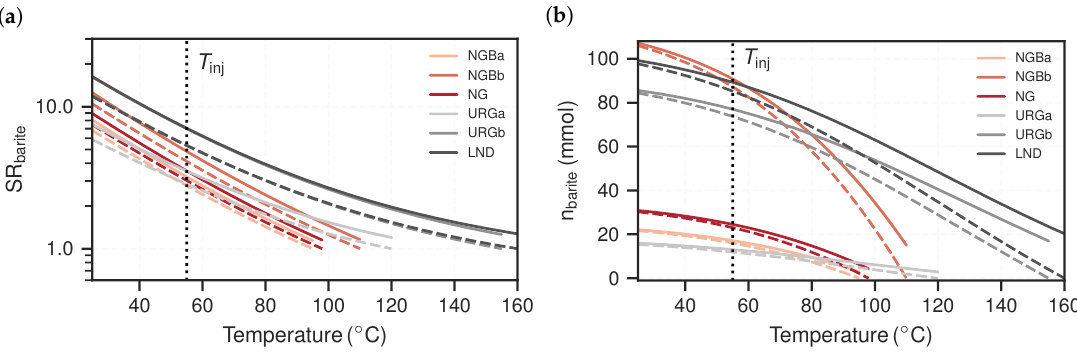
Figure 5. ( a ) Barite saturation according to reducing temperature for the various geothermal cases. SR barite = 1 represents equilibrium with respect to barite. ( b ) The associated precipitation potential in units of millimoles per produced cubic metre of formation fluid. At respective reservoir conditions, the values are zero since equilibrium is assumed to be the initial state. The solid lines assume system pressures (1MPa) and the dashed lines assume the respective reservoir pressures. The dotted vertical lines indicate the assumed injection temperature ( T inj